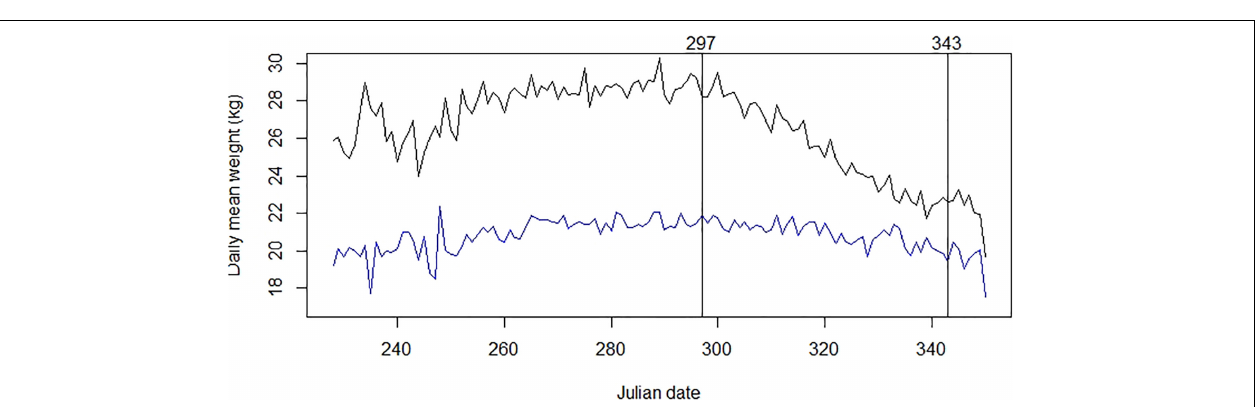
FIGURE 3 | Mean daily standardized body mass of Alpine chamois (black broken line), trends (blue line), Julian date of estimated structural changes (dashed lines, labeled at the top), and 95% confidence intervals of estimated structural change date (red bars). Table 1 provides details about sample size and origin of data.